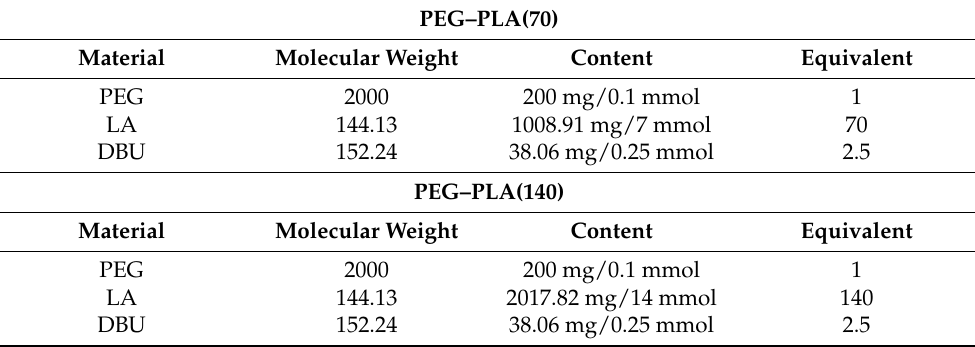
Table 1. Properties of PEG–PLA used in the experiments.